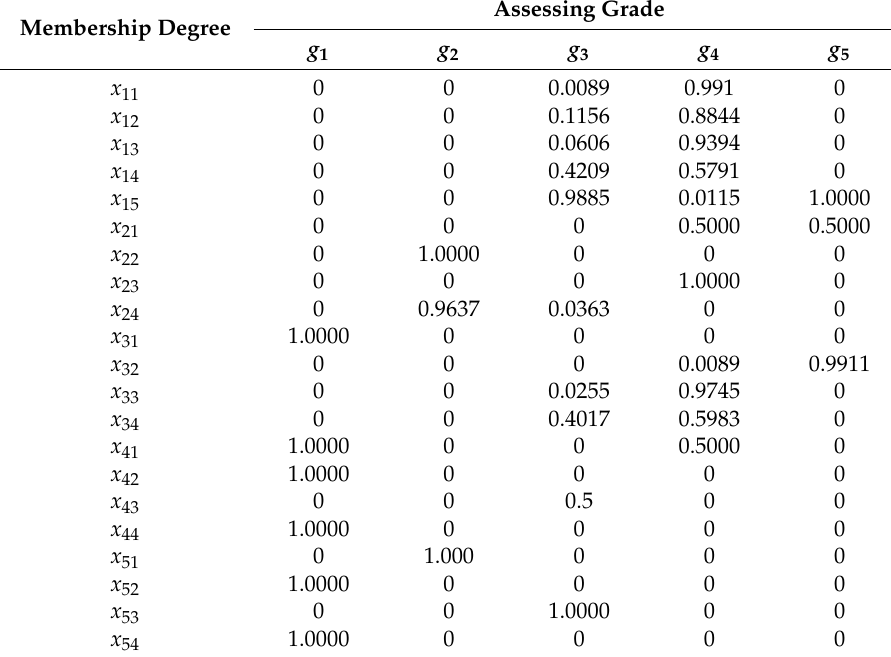
Table 6. Calculation of the membership